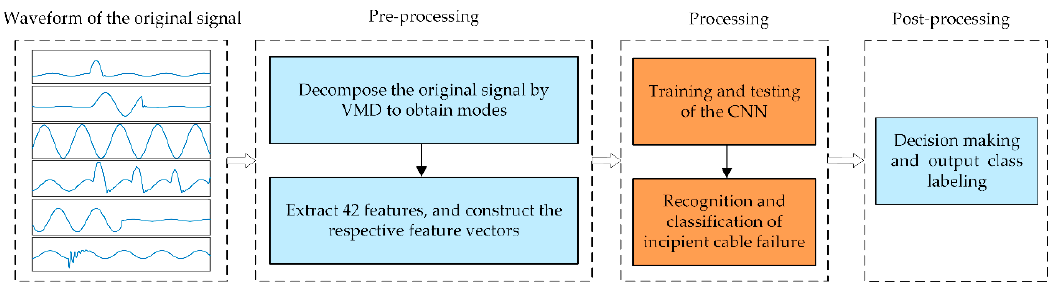
Figure 1. Main structure of the proposed incipient cable failure recognition and classification process.